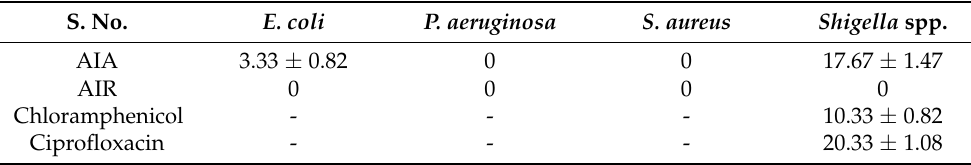
Table 4. Measurement of the zone of inhibition (mm) of test bacteria. S. No. E. coli P. aeruginosa